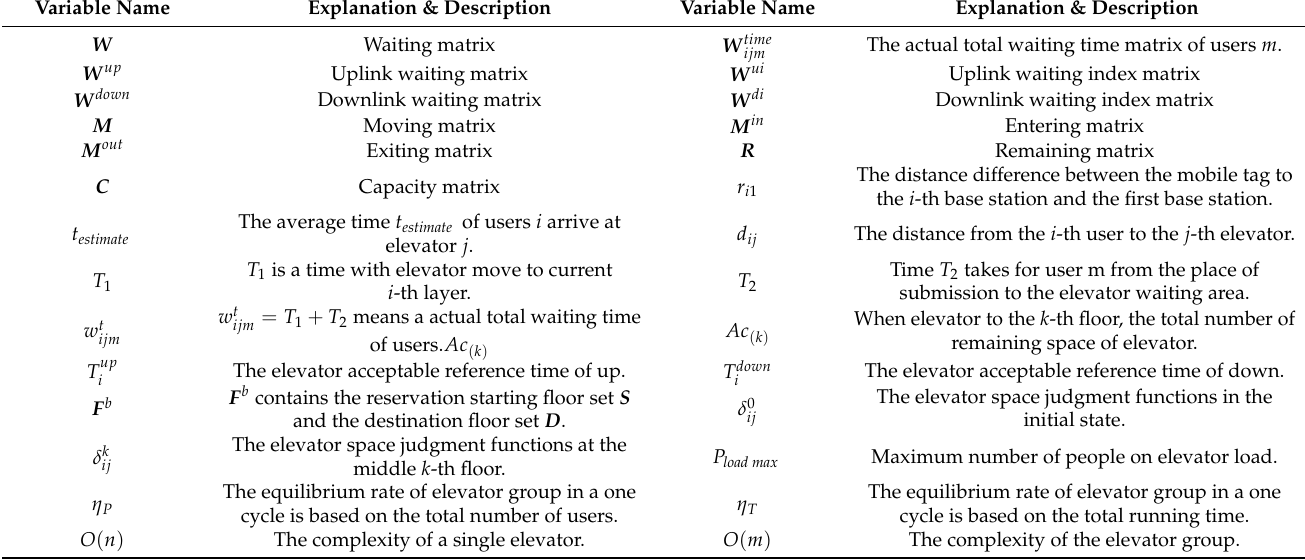
Table 1. All the key variables in models are summarized and